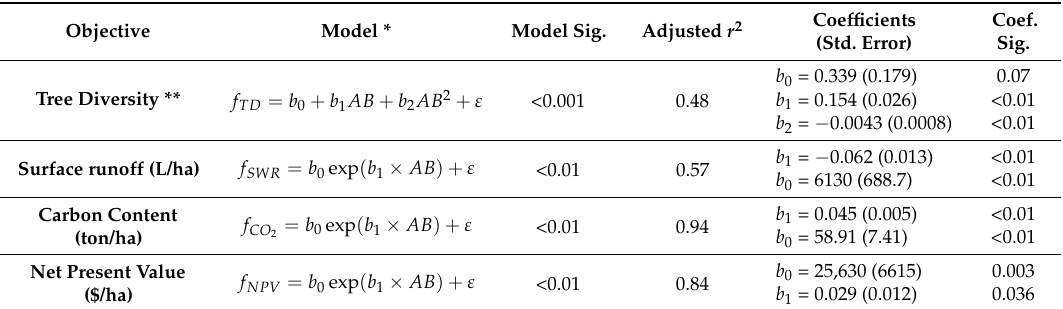
Table 2. Regression models and goodness-of-fit statistics of the ecosystem services evaluated in Molinillos,